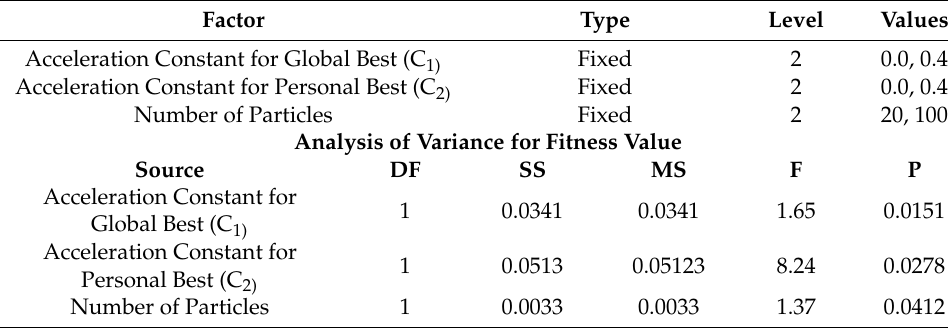
Table 4. ANOVA results for PSO factor.